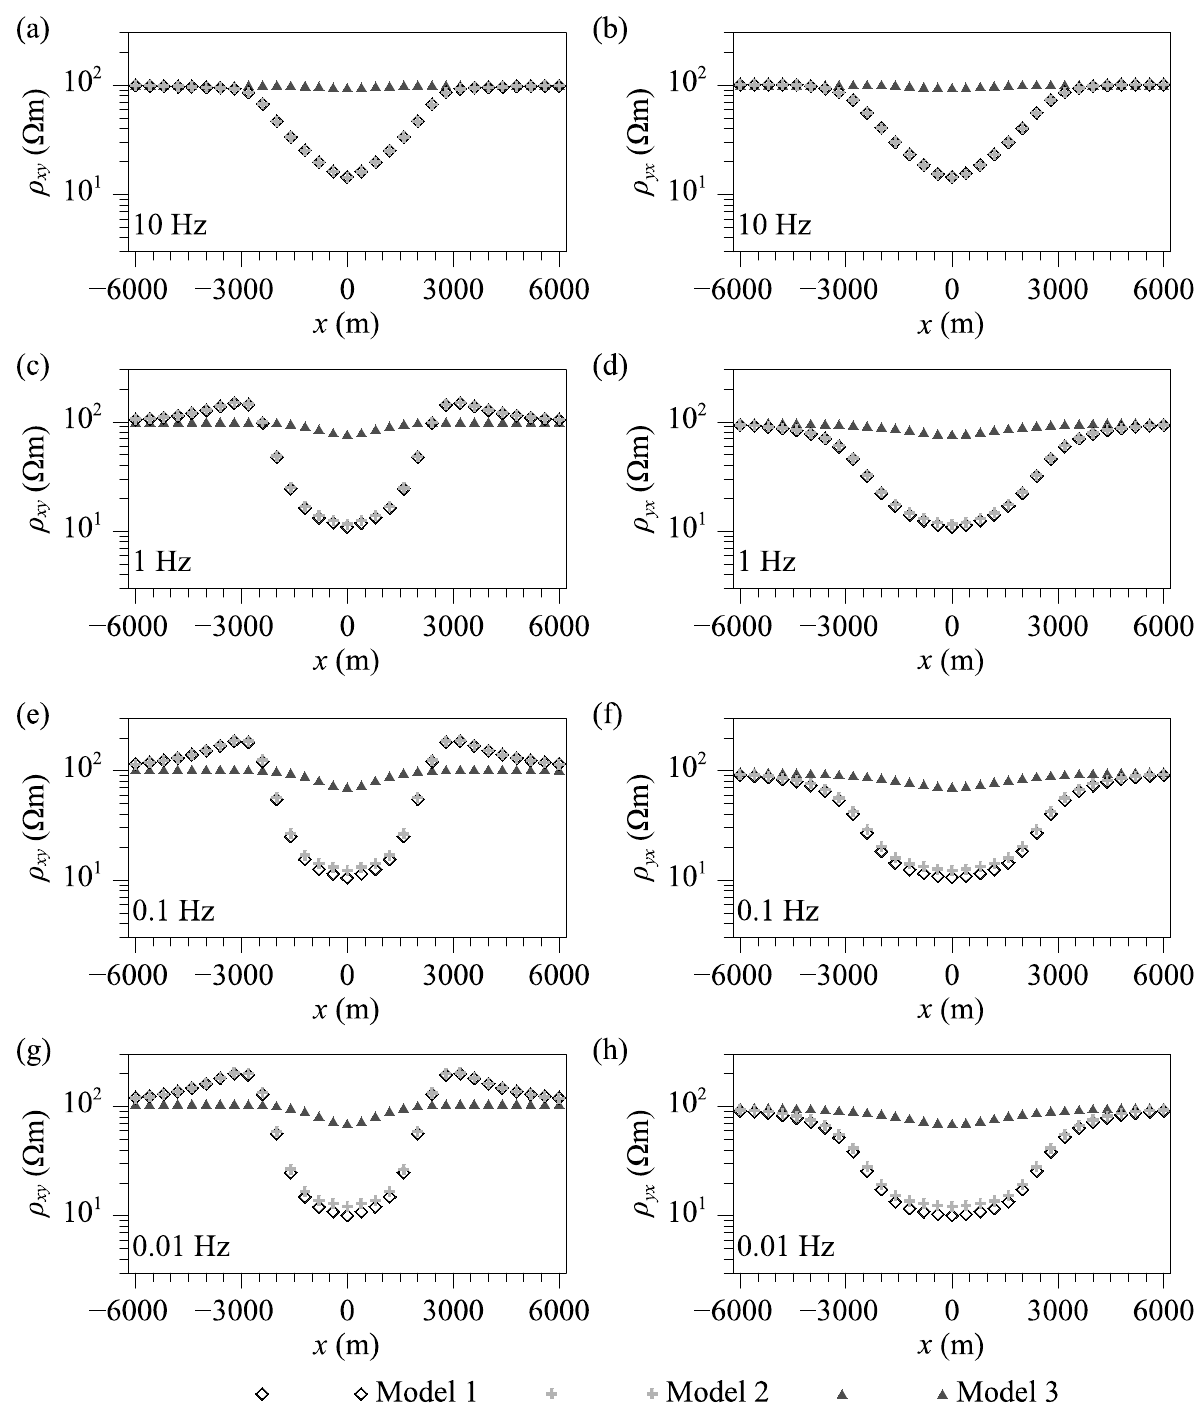
Figure 6. The curves of apparent resistivity for the models representing the hydrothermal system, as shown in Figure 5. The resistivity information of Models 1, 2, and 3 is shown in Table 3. ( a , b ) are for 10 Hz, ( c , d ) are for 1 Hz; ( e , f ) are for 0.1 Hz, ( g , h ) are for 0.01 Hz.